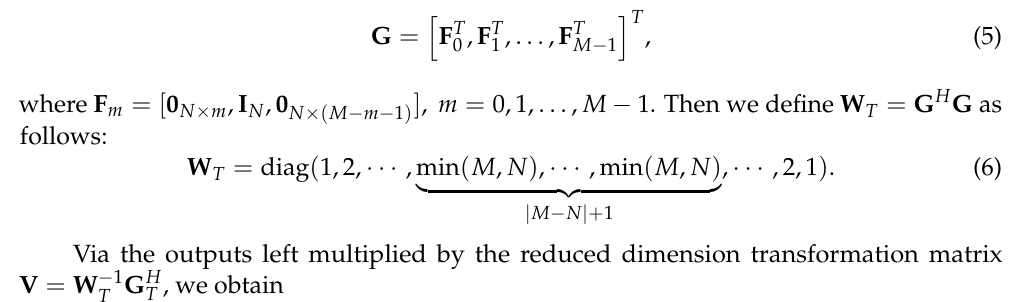
represent the radar cross section (RCS) coefficients, the Dop-